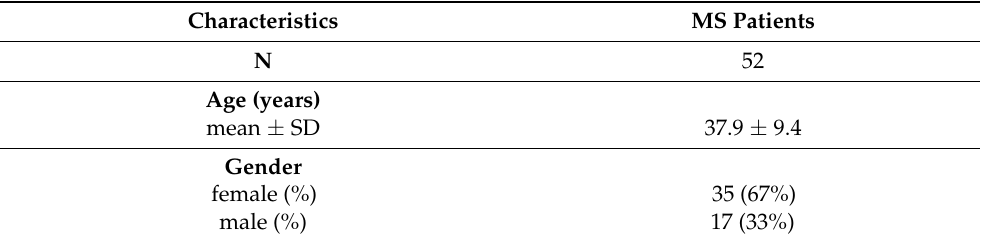
Table 1. The basic demographic and clinical data of MS